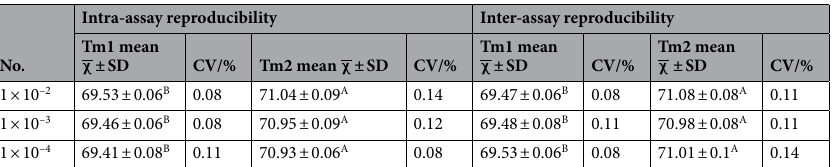
Table 1. Reproducibility assay of the HRM method. Different uppercase letters in the same row mean extremely significant difference (P = 0.000 < 0.01).